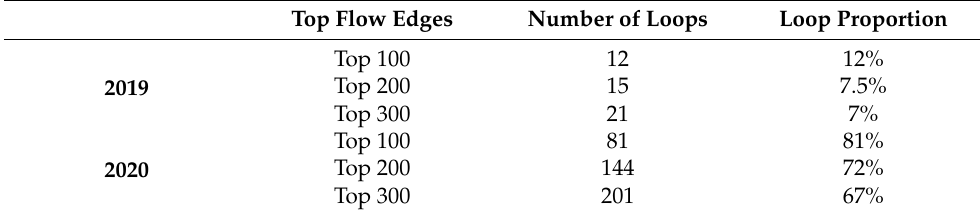
Table 3. The proportion of the loops in top flow edges in two time periods of 2019 and 2020.